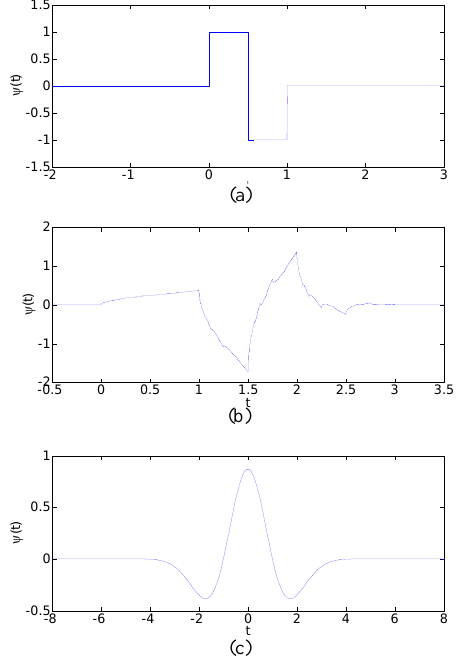
Figure 5. One-level 2D wavelet decomposition example. (a) Crop fields in Belgium, in May 2005 (Source: Belgian Earth Observation Platform, Space Imaging Europe). (b) One-level wavelet representation.